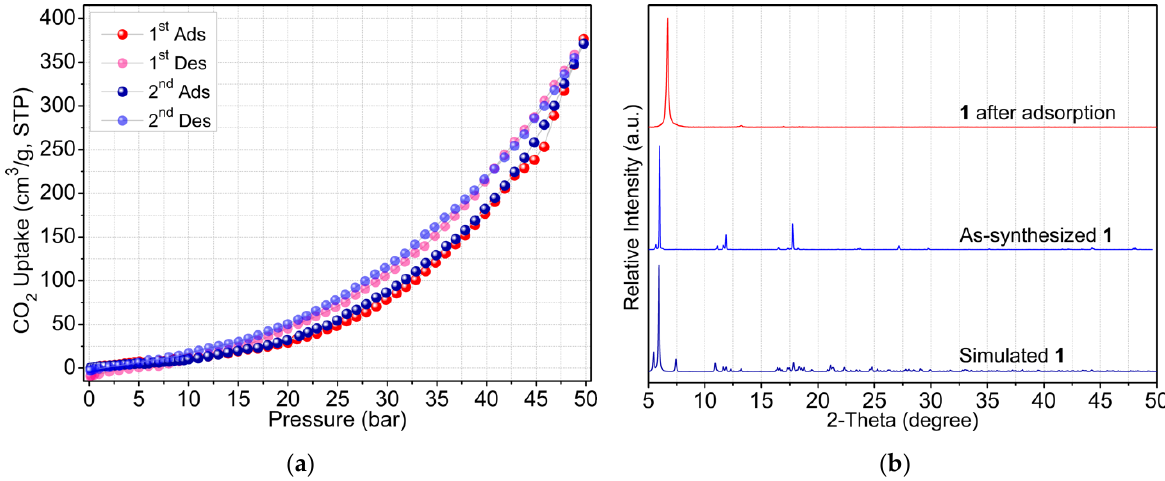
Figure 5. ( a ) Adsorption–desorption isotherms of 1 for CO 2 at 298 K. ( b ) PXRD patterns of 1 before and after CO 2 adsorp- tion.